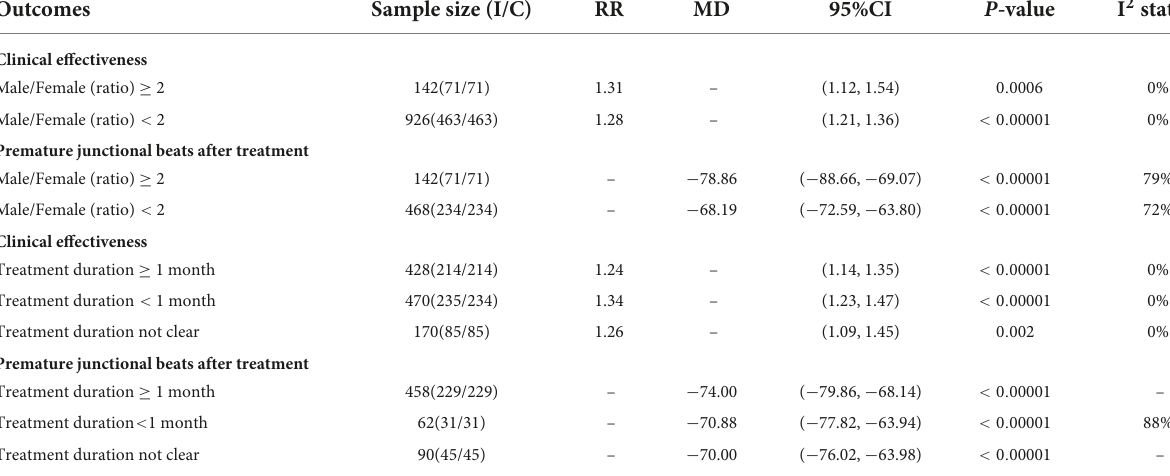
TABLE 3 Subgroup analysis of two reported outcomes according to different treatment durations and male/female